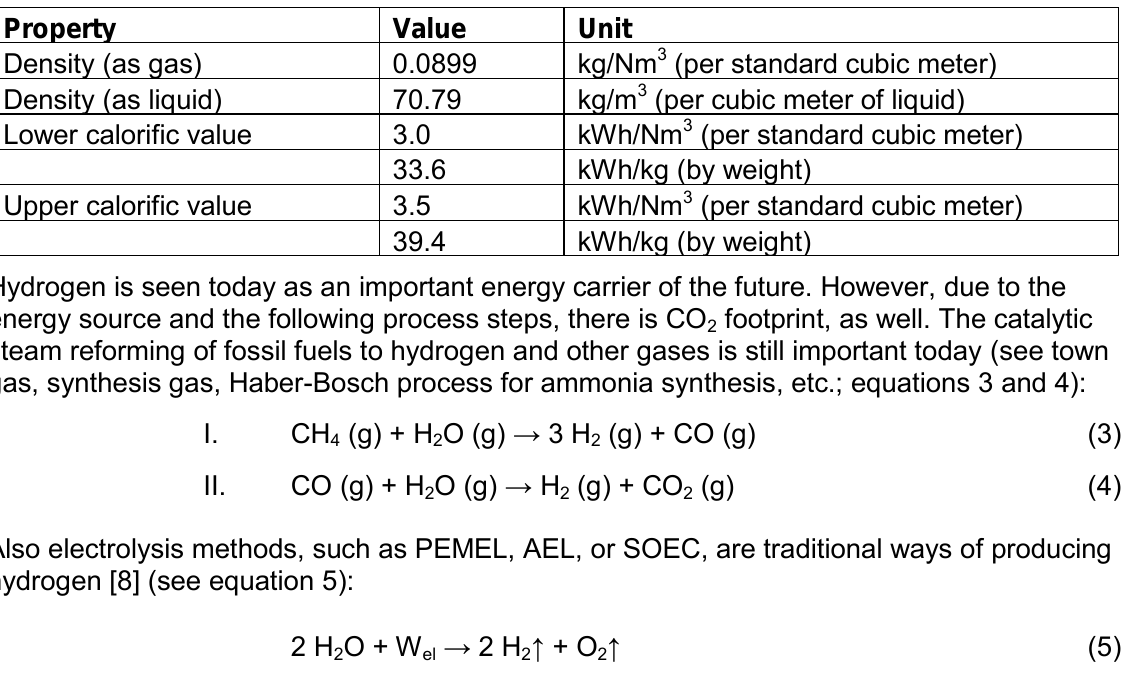
Table 1. Properties of hydrogen [7],[8].